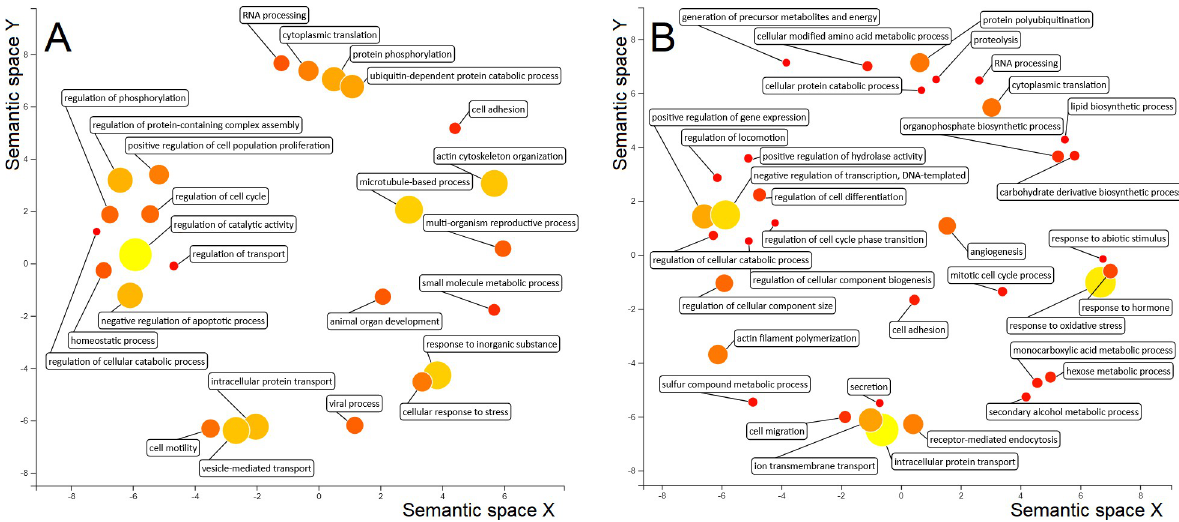
Fig 7. ReViGO plot showing the main GO terms within the Biological Process (BP) category in MPSIEC. The BP GO terms corresponding to up- and down-regulated proteins in the cytosol (A) and membrane (B) extracts of MPSIEC after incubation with FhNEJ are shown. The size and colour of each circle represents the Nodescore of each GO term, and the spacing between circles refers to the similarity between the represented terms.